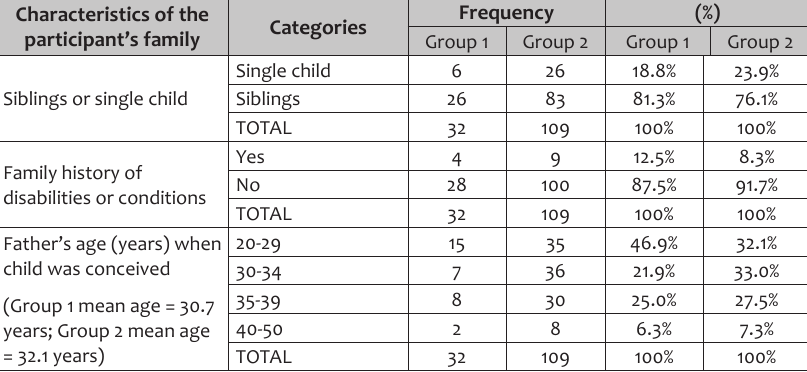
Table 3: Comparison of family characteristics between Group 1 (n=32) and Group 2 (n=109) Characteristics of the participant’s